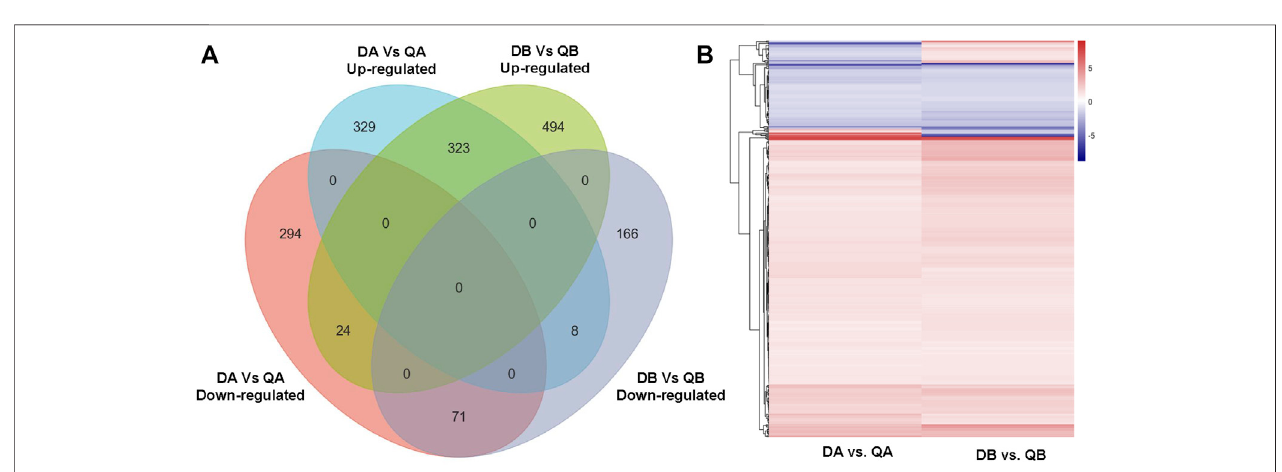
FIGURE 9 | Venn diagram (A) and heatmap (B) showing co-expressed DEGs in the DA vs. QA and DB vs. QB comparisons.